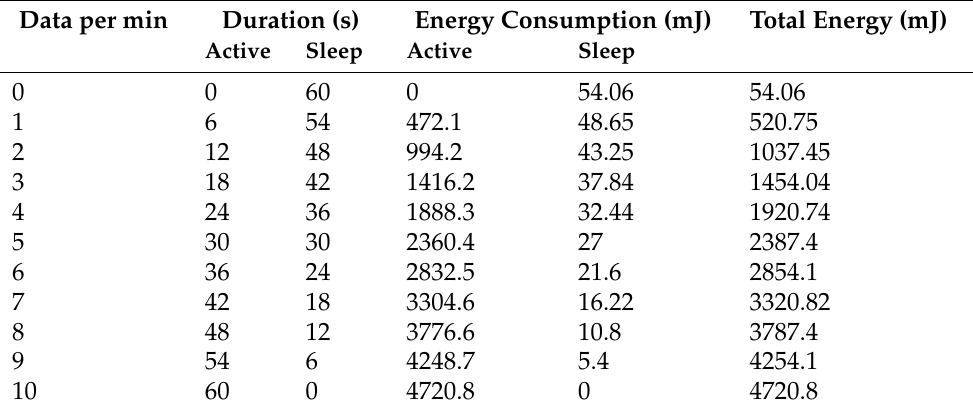
Table 2. Energy consumption profile of the test IoT device for one